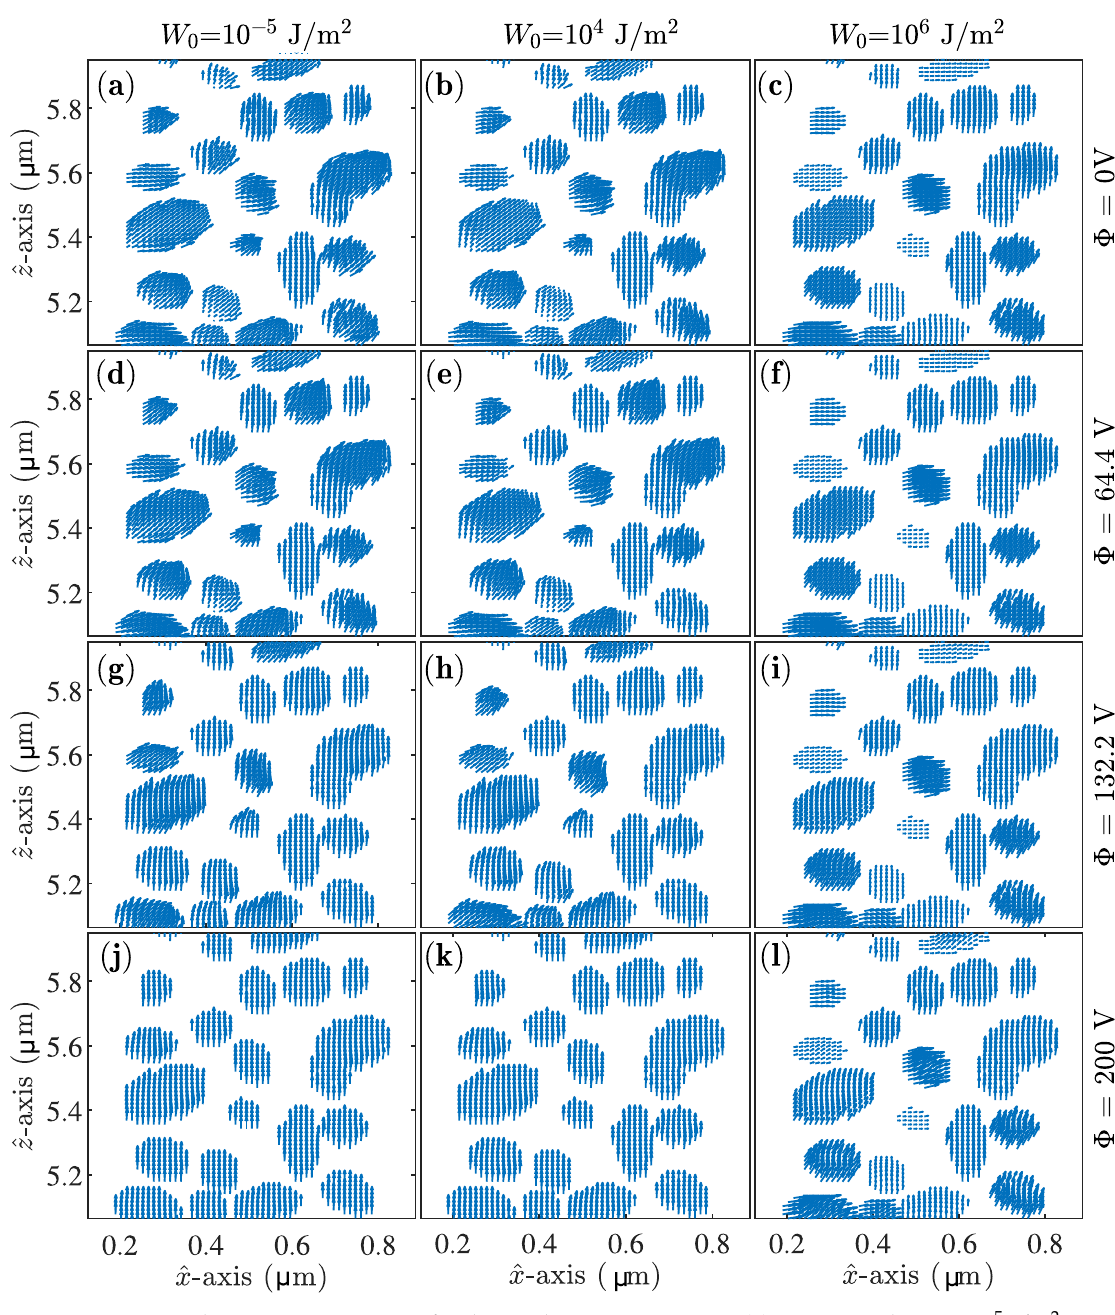
Figure 6. LC director representation for the ˆ x ˆ z plane at y = 0.49 µ m. ( a ) Φ = 0 V and W 0 = 10 − 5 J/m 2 . ( b ) Φ = 0 V and W 0 = 10 4 J/m 2 . ( c ) Φ = 0 V and W 0 = 10 6 J/m 2 . ( d ) Φ = 64.4 V and W 0 = 10 − 5 J/m 2 . ( e ) Φ = 64.4 V and W 0 = 10 4 J/m 2 . ( f ) Φ = 64.4 V and W 0 = 10 6 J/m 2 . ( g ) Φ = 132.2 V and W 0 = 10 − 5 J/m 2 . ( h ) Φ = 132.2 V and W 0 = 10 4 J/m 2 . ( i ) Φ = 132.2 V and W 0 = 10 6 J/m 2 . ( j ) Φ = 200 V and W 0 = 10 − 5 J/m 2 . ( k ) Φ = 200 V and W 0 = 10 4 J/m 2 . ( l ) Φ = 200 V and W 0 = 10 6 J/m 2 .